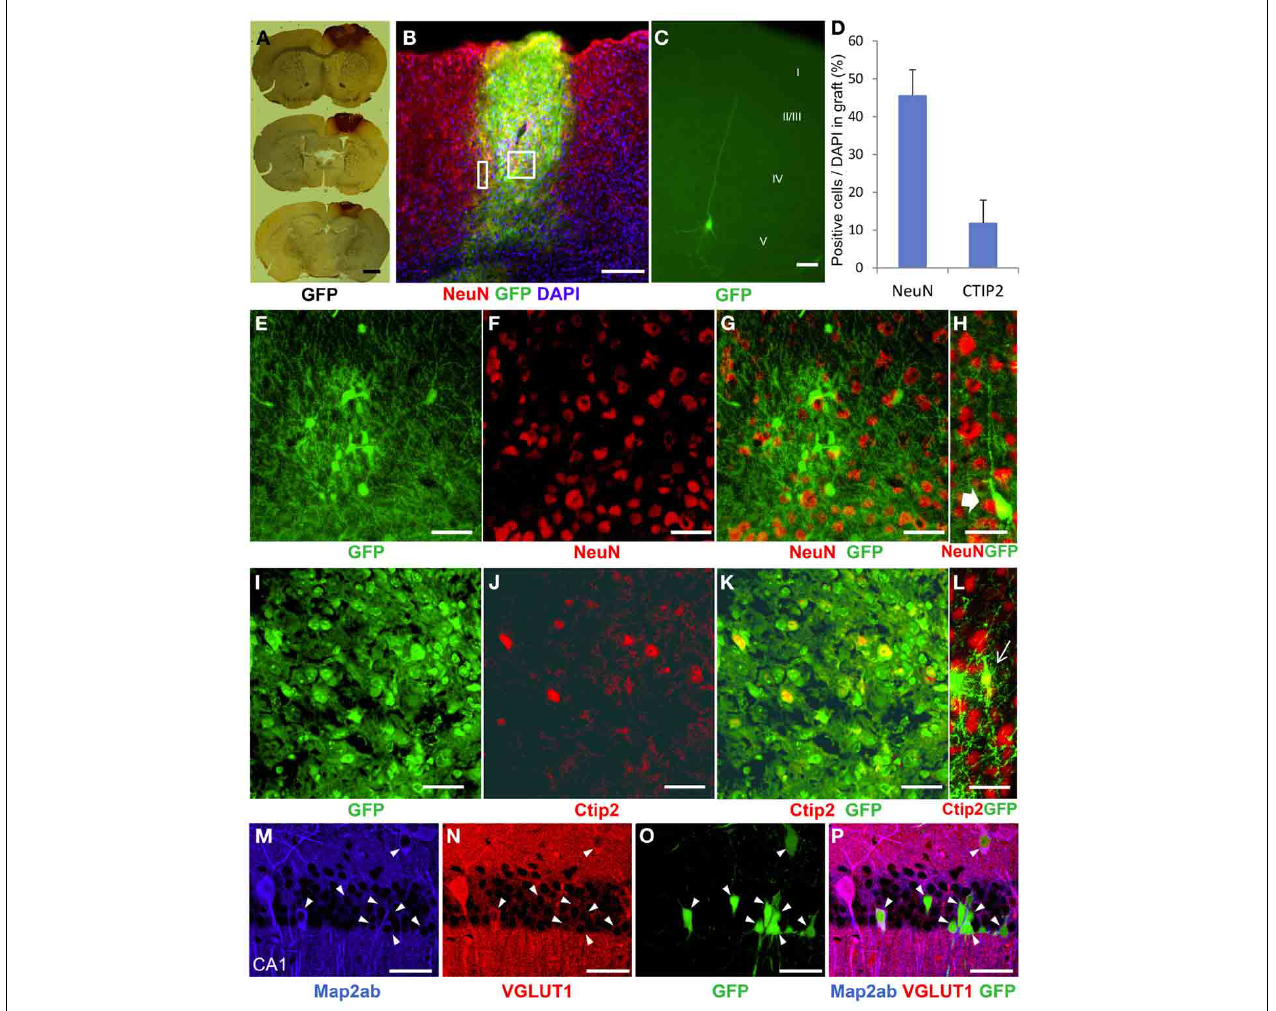
in the layer V cortical area. (D) Frequently distribution of neuronal markers, NeuN and Ctip2, as a percentage of DAPI in the graft. Core region of graft showed co-localization of NeuN (F) or Ctip2 ( J ) and GFP ( E,I,G,K ). Some NeuN-positive (H) or Ctip2-positive cells (L) demonstrate monopolar morphology. (M–P) Migrated or leaked NPCs into the hippocampus at transplantation differentiated to CA1 pyramidal neurons with apical dendrites and also expressed the Map2ab neuronal marker and glutamate (arrow heads). Scale bar; (A) 1000um, (B) 200um, (C) 20 um, (E–P)